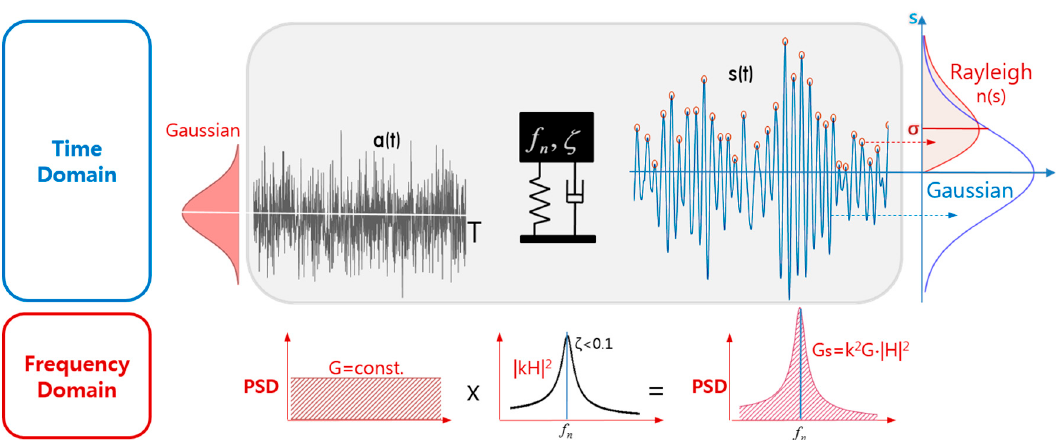
Figure 2. Velocity response of the SDOF system to Gaussian random acceleration input with constant power spectral density (PSD) shows Gaussian distribution. The peak distribution of the response becomes a Rayleigh function. The standard deviation of the response distribution matches the scale parameter of the Rayleigh function. a(t) is input acceleration and s(t) is stress waveform (above). Stress PSD is calculated by multiplying input PSD and squared stress amplitude of system’s frequency response function (below).